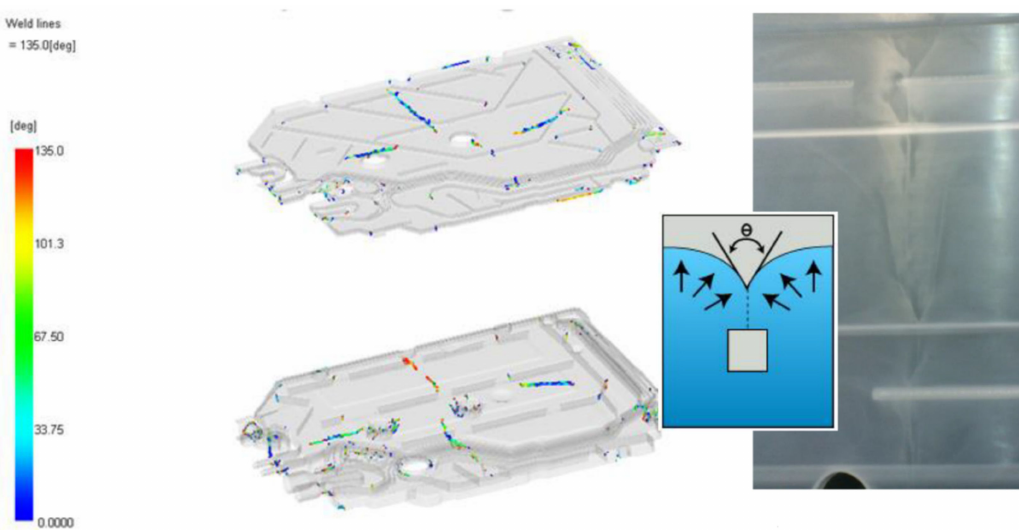
Figure 17. Temperature connection points of